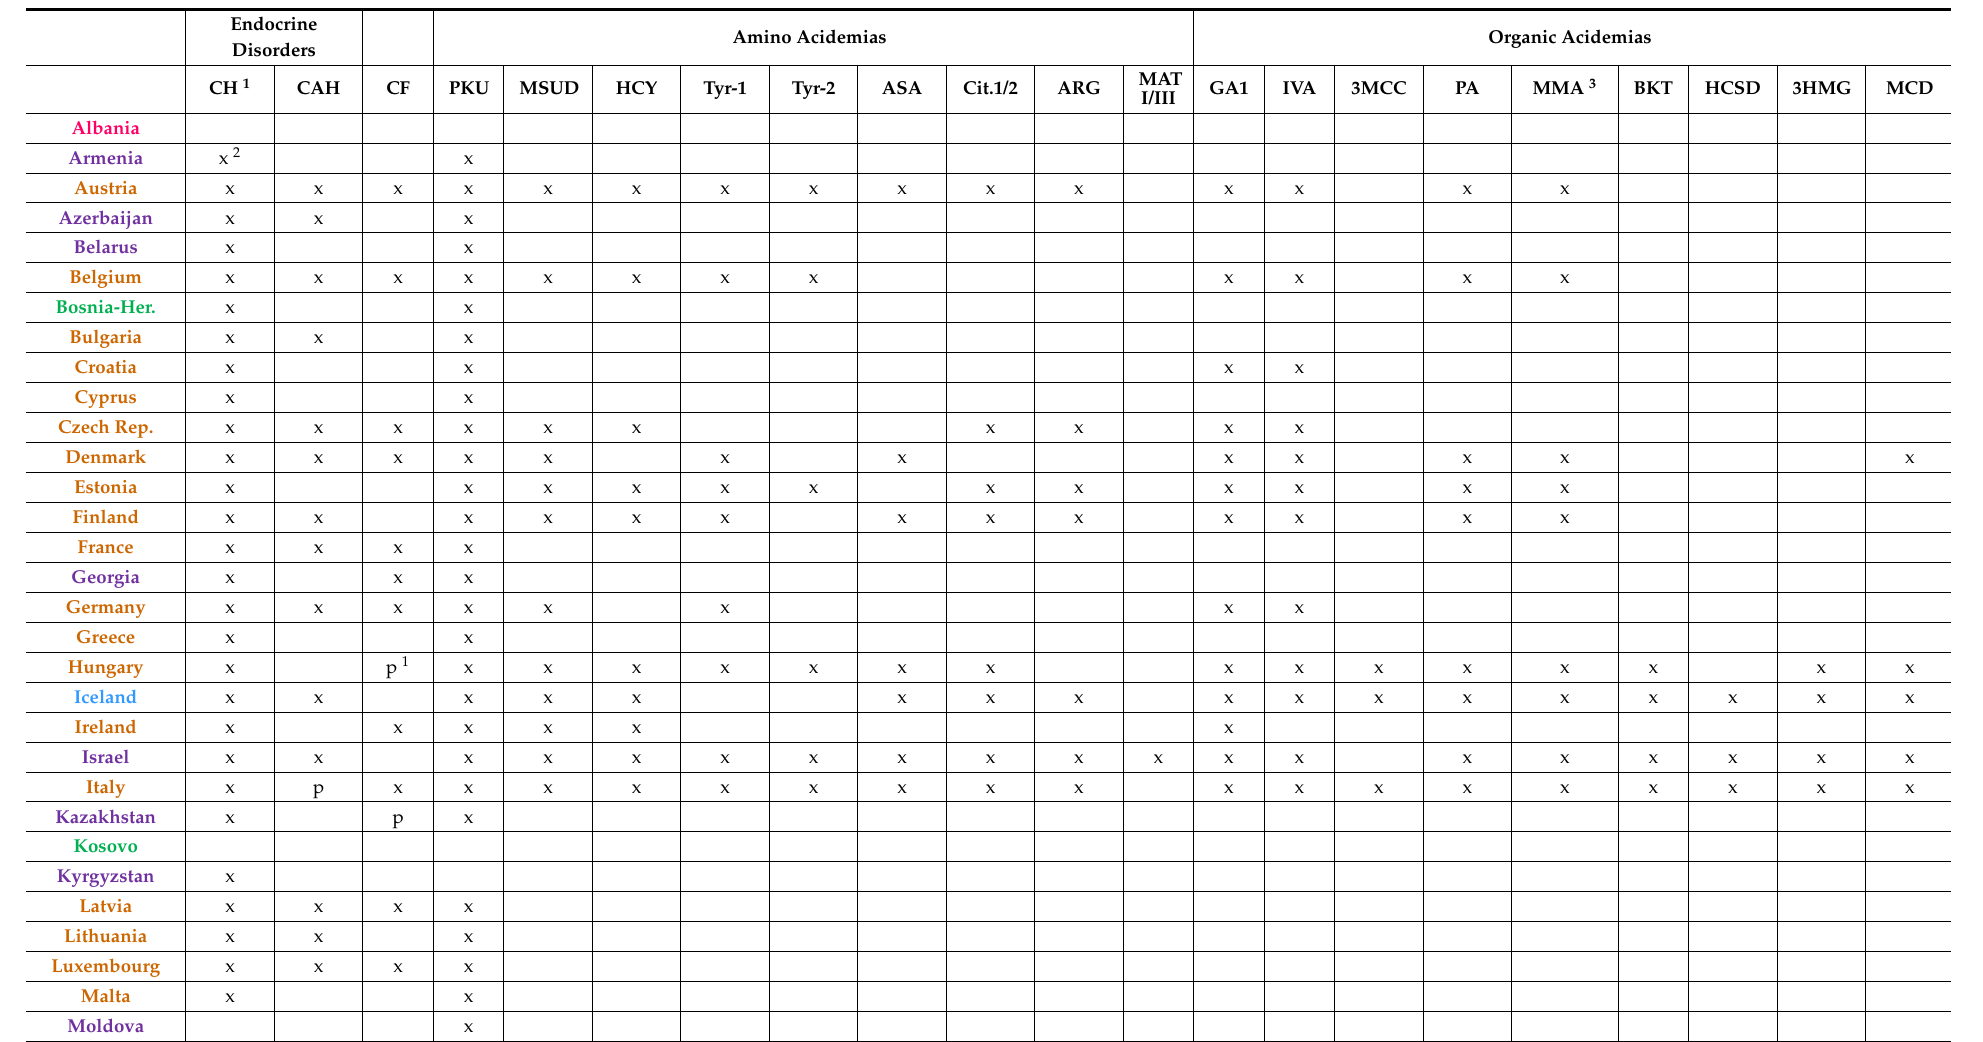
Table 2. Screening panel, part